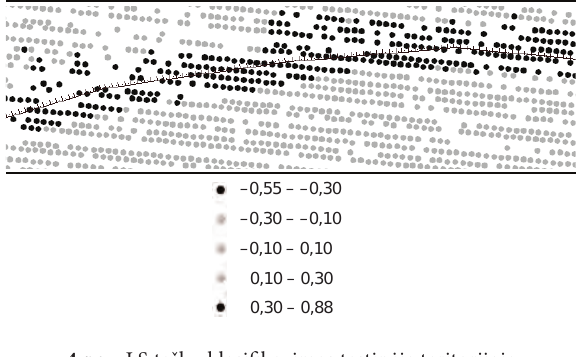
Fig. 4. The classification of LIDAR points in the tested territory (distance,